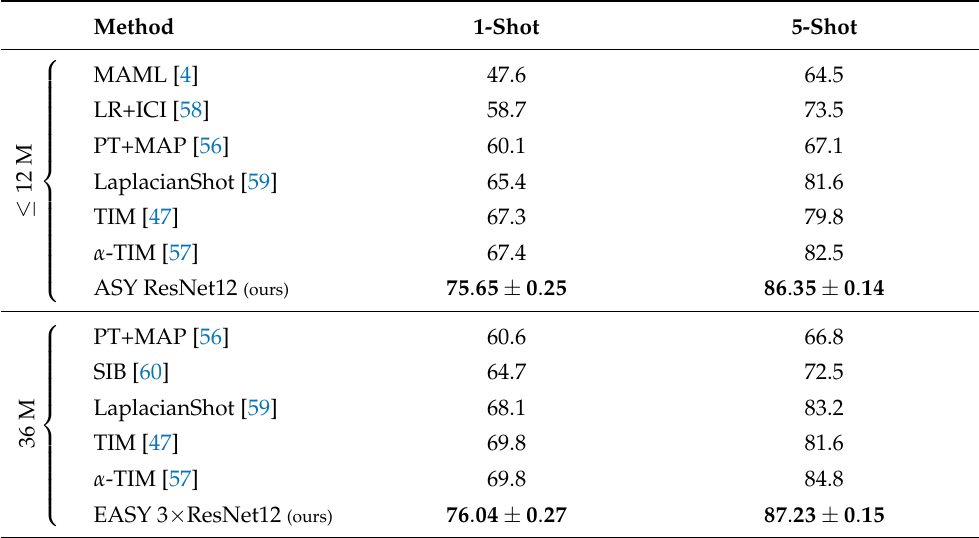
Table A1. The 1-shot and 5-shot accuracy of state-of-the-art methods and the proposed solution on MiniImageNet in the imbalanced transductive setting.